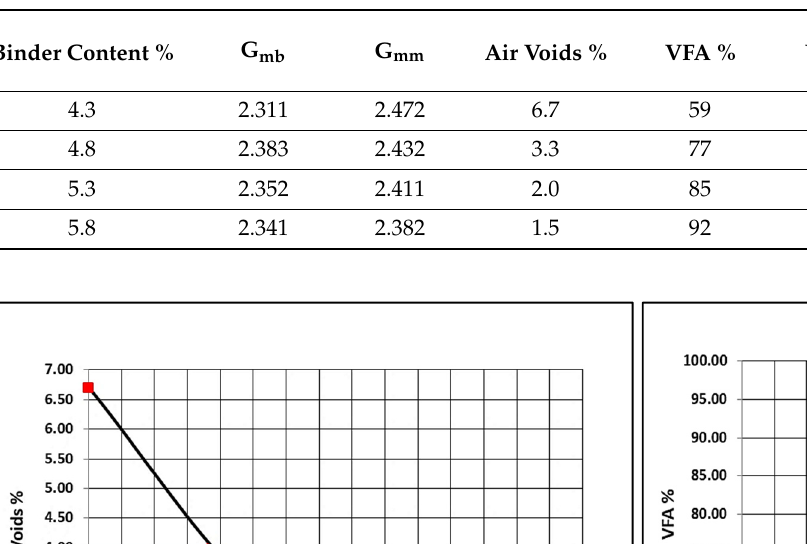
Table 16. Trial mixture to conduct the optimum asphalt content.